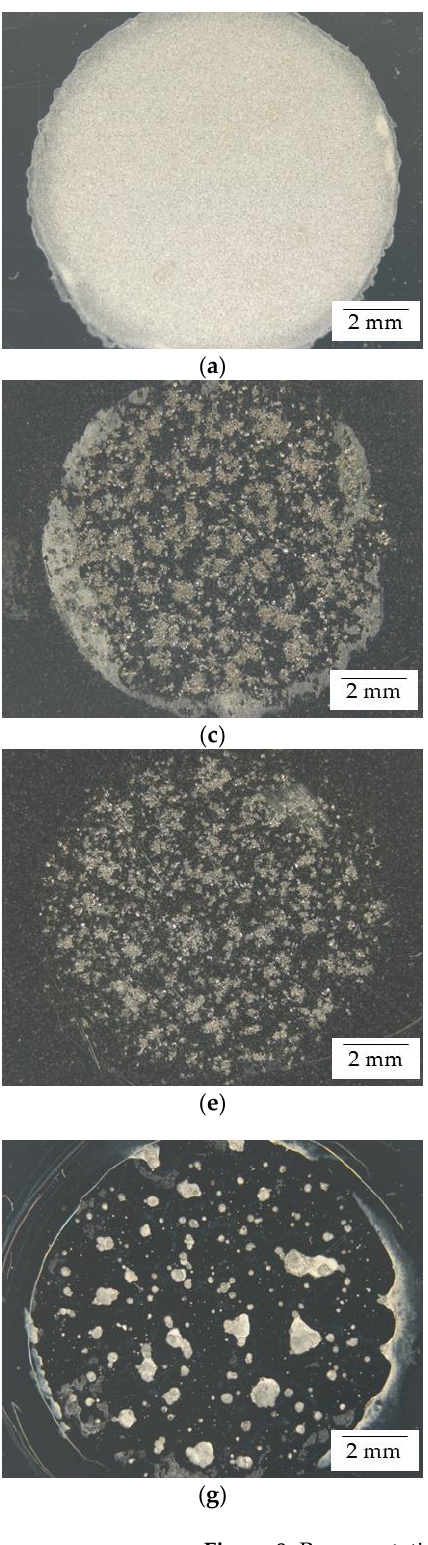
Figure 8. Representative top views and cross-sectional images of ( a , b ) reference material mild steel, ( c , d ) AISI 316L HVAF coating on mild steel, ( e , f ) AISI 316L HVAF coating on stainless steel, and ( g , h ) reference material stainless steel after potentiodynamic polarization in 3.5% NaCl gel electrolyte up to +1000 mV relative to the OCP.